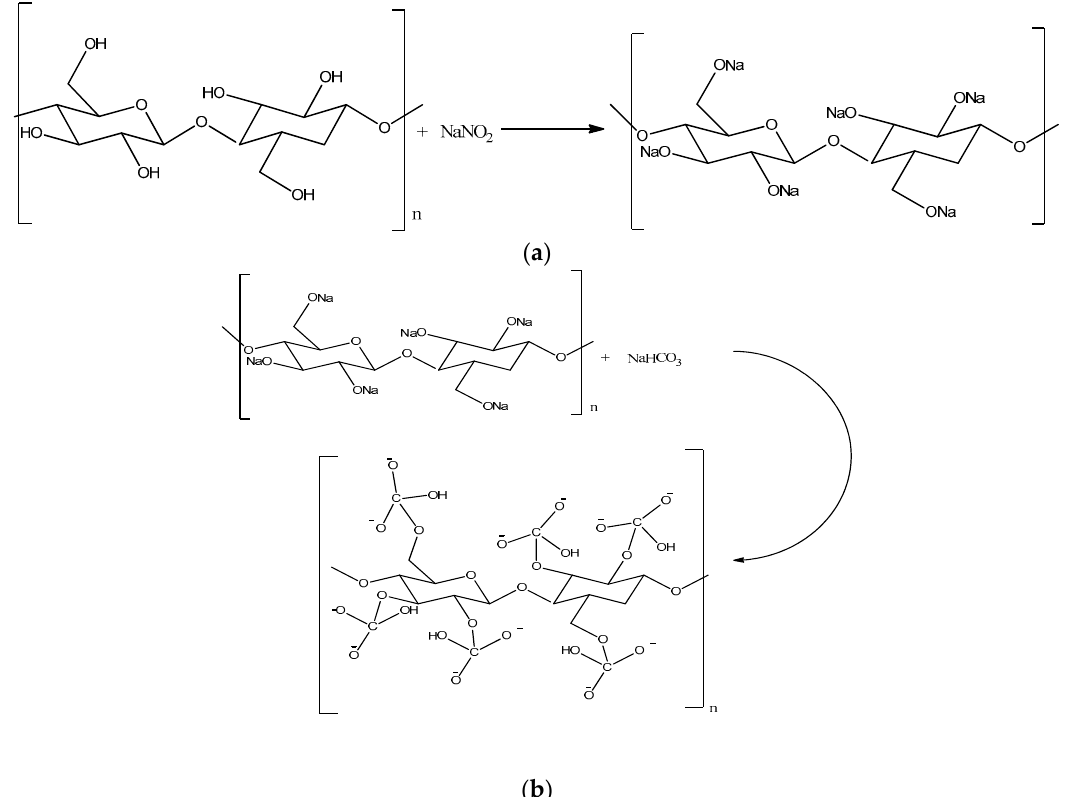
Figure 1. Proposed reaction scheme for the ( a ) modification of CNC with sodium nitrite (NaNO 2 ), and ( b ) conversion of the sodium salt of cellulose to carboxylate anion across the surface of the modified material. Reprinted from [21]. Copyright (2019), with permission from Elsevier.